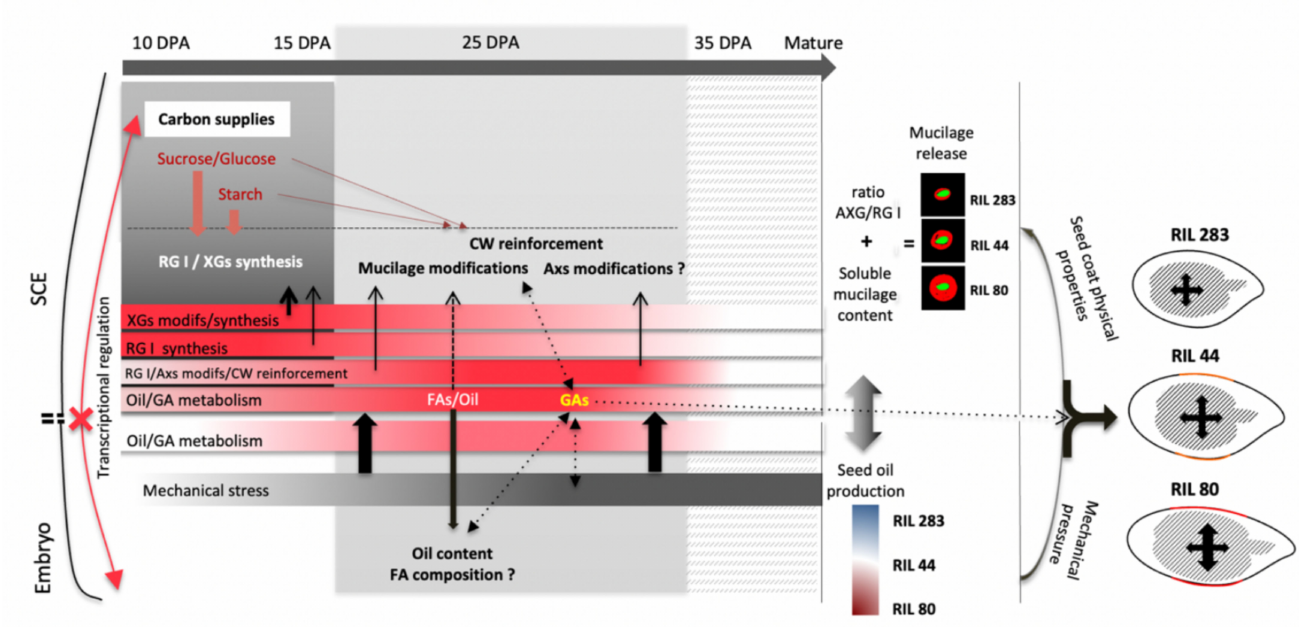
Figure 9. Simplified conceptual model of the possible interactions between the mucilage, FA and GA metabolisms during flax seed tissues development. The most relevant results of this study from our multidisciplinary approach are shown in the diagram, including carbon allocation and mechanical forces from the pressure exerted by the embryo on the SCE. The red arrows indicate that not more carbon allocations between both tissues through the symplasmic pathways are not supposed to exist anymore at 10 DPA. The most relevant tissues- and development stage-specific events are merged in the dark grey and grey boxes. The color code of the red bars indicates the importance of the transcriptional regulation processes for each specific biosynthetic pathway. Phenotypes of the RILs used in this study and corresponding to the mucilage-released as well as FAs contents and the seed size and shape are reported at the end of the seed development